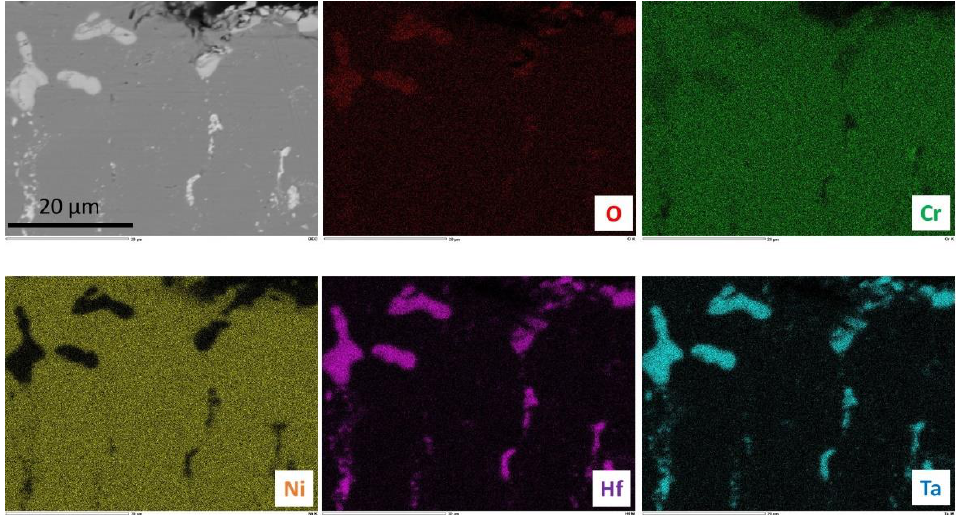
Figure 11. X-maps showing the elemental repartition in the subsurface of the oxidized T alloy.